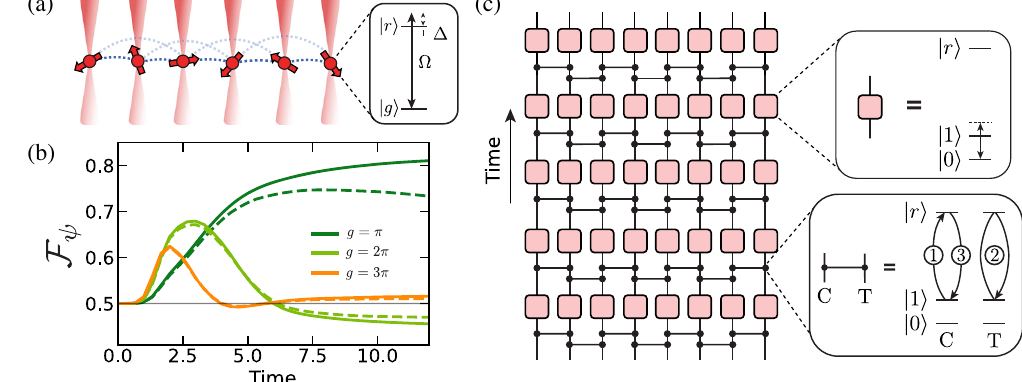
ˆ ˆ Z O ; and time i ¼ i 0 . 9 , Δ − 1 . 5 , and J 1 (for all i ). 0 ¼ i ¼ i ¼